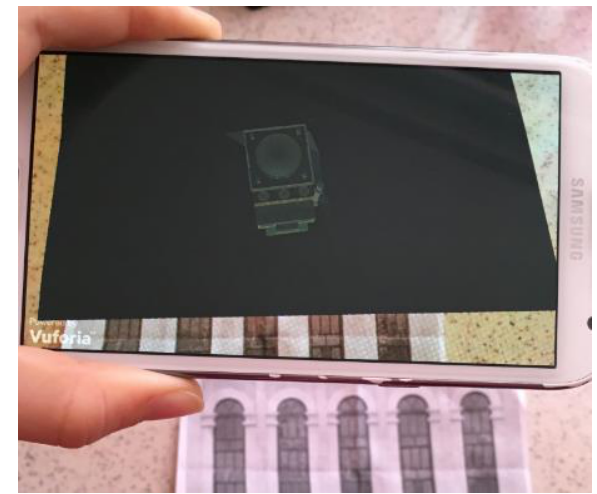
Figure 5. Mobile Application